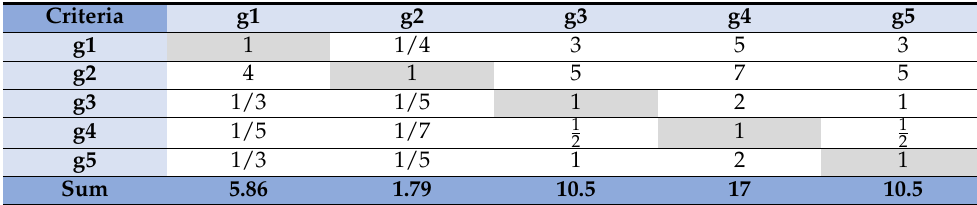
Table 9. AHP evaluation matrix (Part A).